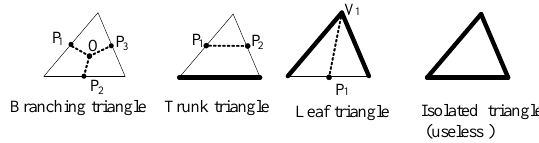
Figure 1. Four triangle types and their skeleton